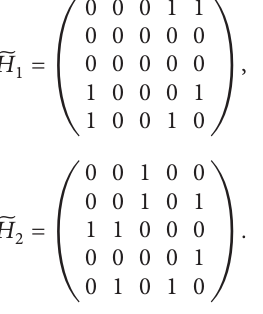
(𝑡) and 𝑓 (𝜏 ) in Example 1 2 𝑘